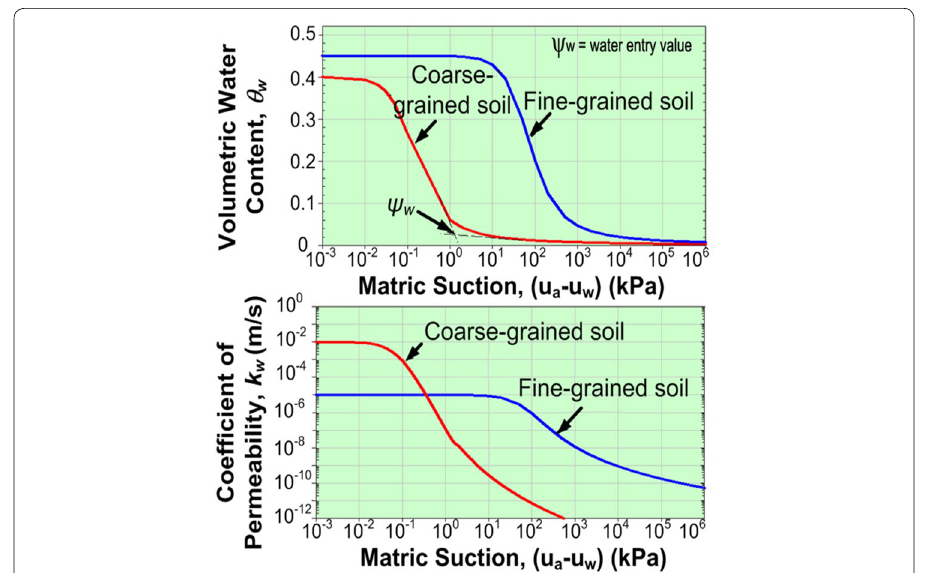
Fig. 9 Soil-water characteristic curves and permeability function of capillary barrier system